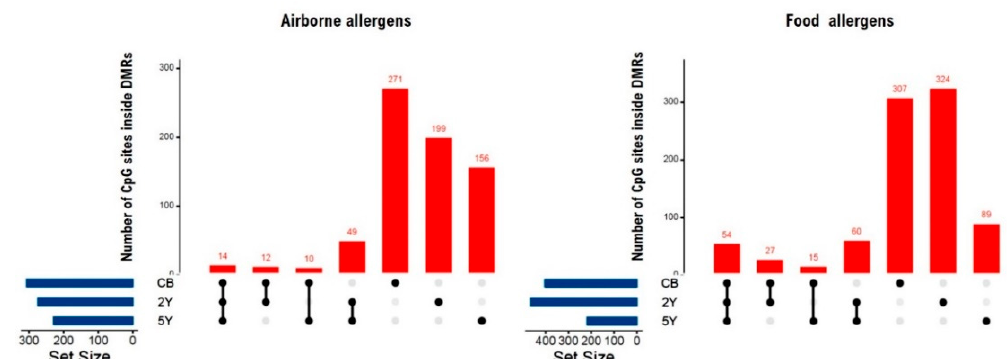
Figure 3. Bar plot showing the total number of CpG sites located within the significant differentially methylated regions (DMRs) associated to airborne and food sensitization in ALADDIN (Assessment of Lifestyle and Allergic Disease During INfancy). The total number of CpG sites that are associated to each phenotype at each time point is reported above the red bars. Black dots represent the intersected sets assigned to the red bar. The blue bars indicate the total number of CpGs within DMRs per time point; the overlap of cg numbers was used as proxy of DMR composition per time point. Detailed information on the CpG sites within the DMRs associated with IgE sensitization is presented in Spreadsheet File S2 (airborne allergens) and Spreadsheet File S3 (food allergens).